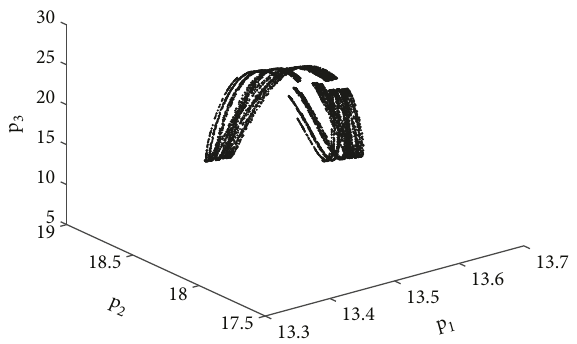
= α = 0 005 and α 1 2